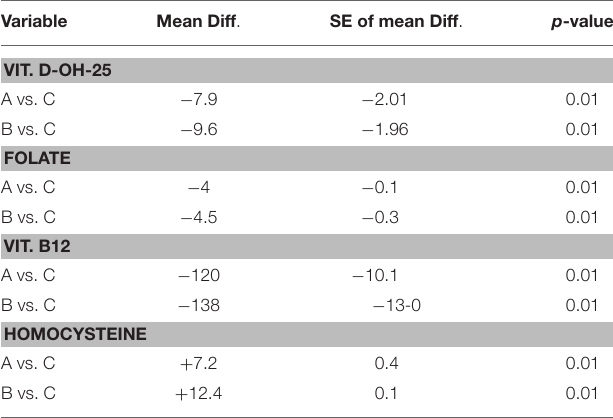
TABLE 4 | Multiple comparison analysis (Tukey test) of various biochemical parameters in AD, sVAD, and controls. Variable Mean Diff . SE of mean Diff